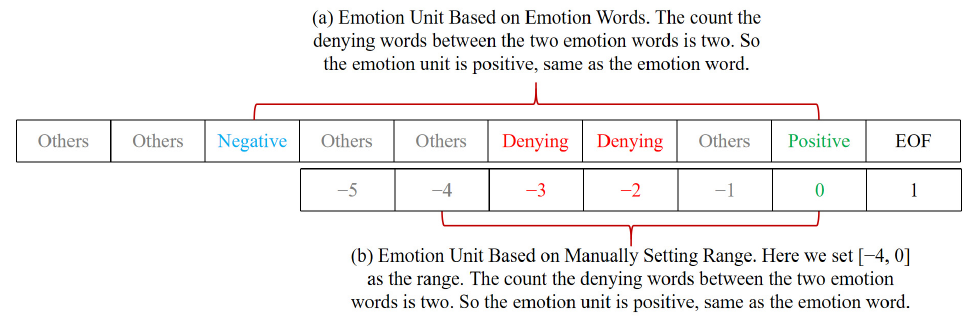
Figure 1. The example diagram of the two definition methods of emotion unit.